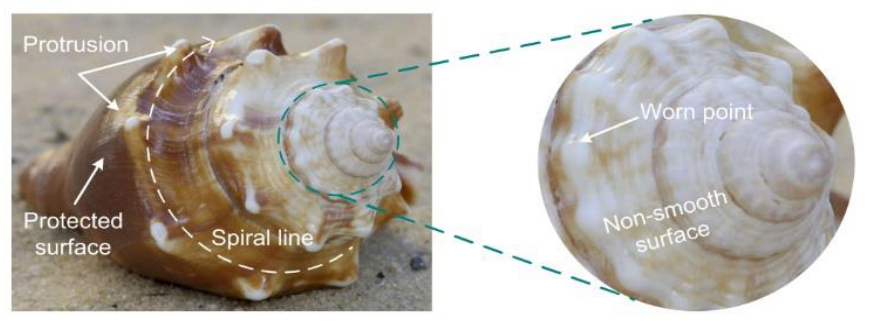
Figure 7. Biological characteristics of a conch [53].